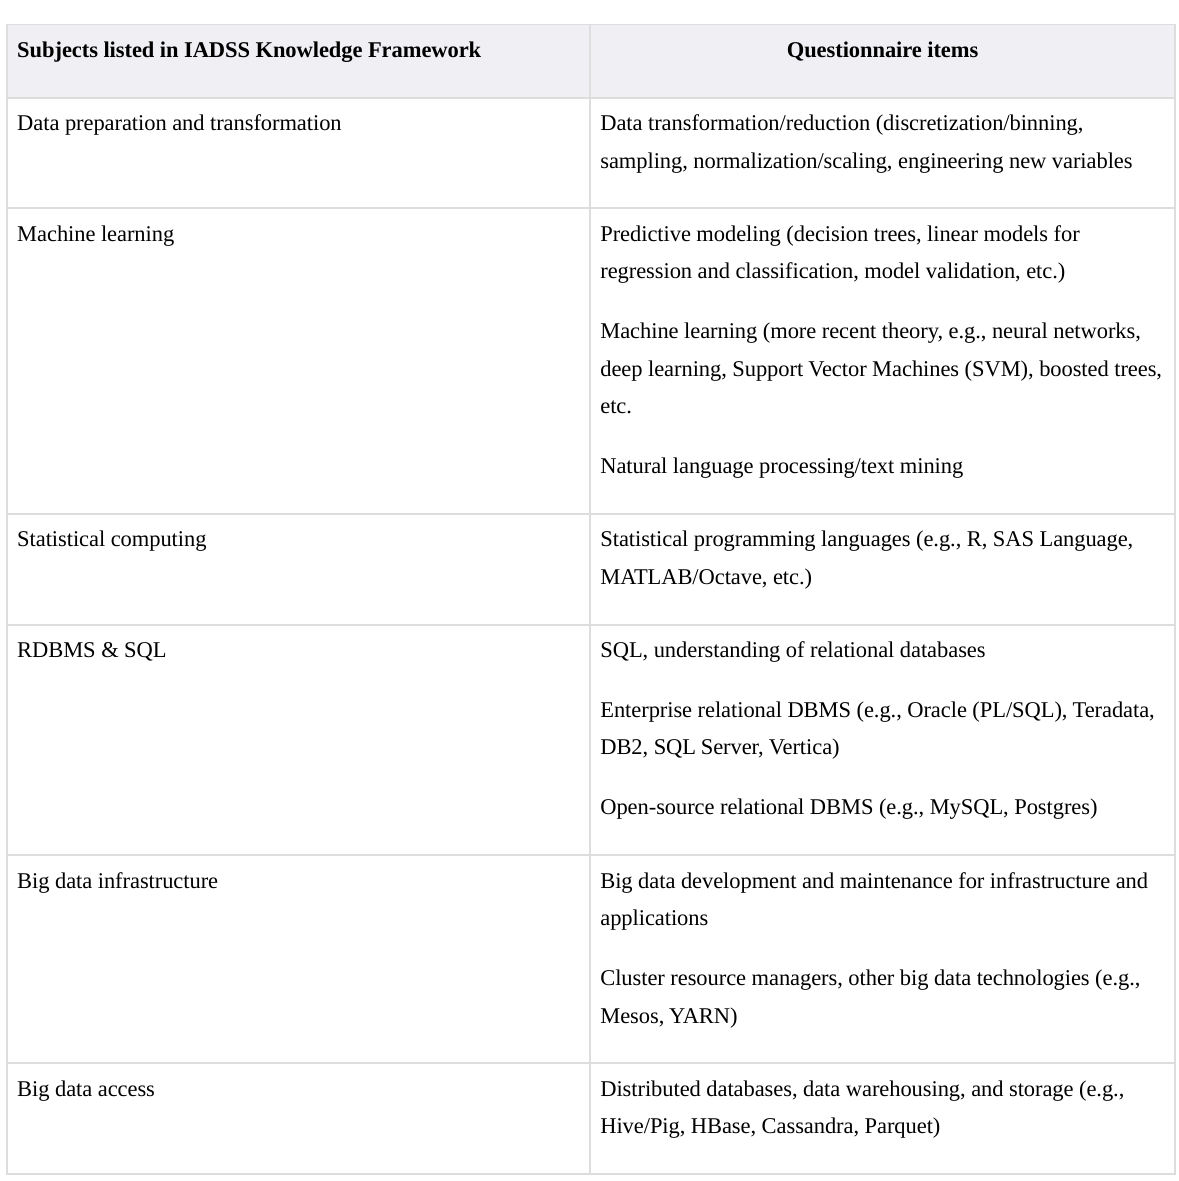
Table 2. Sample questions and corresponding IADSS Knowledge Framework